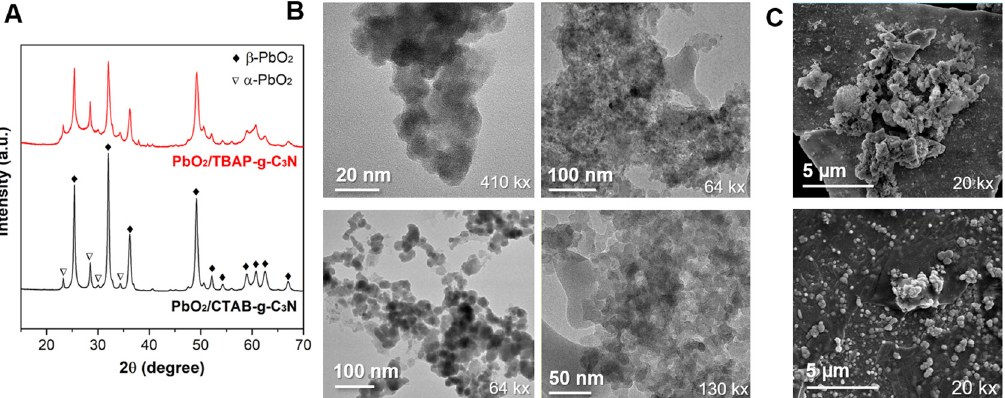
Figure 1. Morphological and microstructural analysis. ( A ) PXRD profiles of PbO 2 -CTAB/g-C 3 N 4 and PbO 2 -TBAP/g-C 3 N 4 , ( B ) TEM micrographs of PbO 2 -CTAB (upper left), PbO 2 -CTAB/g-C 3 N 4 (upper right), PbO 2 -TBAP (lower left), PbO 2 -TBAP/g-C 3 N 4 (lower right) and ( C ) FE-SEM micrographs of PbO 2 -CTAB/g-C 3 N 4 (up) and PbO 2 -TBAP/g-C 3 N 4 (down).